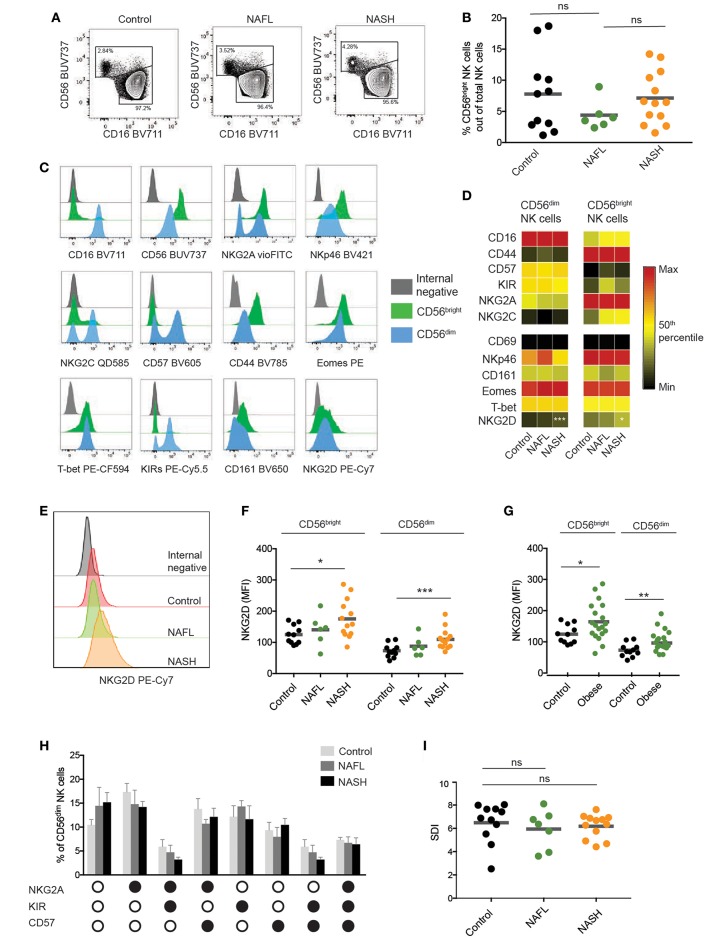
Phenotypic characterization of circulating NK cells from NAFLD patients. (A) Representative flow cytometry plots of NK cells from healthy, NAFL, and NASH patients. (B) Frequency of CD56bright NK cells out of total NK cells in peripheral blood of healthy controls (n = 13), NAFL patients (n = 9), and NASH patients (n = 16). (C) Representative histograms for the indicated markers on CD56bright and CD56dim NK cells as well as internal negative control. The plots represent stainings from one healthy donor. (D) Heat map depicting the mean frequency of NK cells expressing CD16, CD44, CD57, KIRs, NKG2A, and NKG2C as well as the mean MFI of CD69, NKp46, CD161, Eomes, T-bet, and NKG2D on CD56dim and CD56bright NK cells for the indicated groups. (E) Representative histogram of NKG2D expression on NK cells from healthy control, NAFL, and NASH patients respectively. (F,G) Scatter plots of NKG2D MFI on CD56dim and CD56bright NK cells from the indicated groups. In (F), healthy controls (n = 11), NAFL (n = 6), and NASH (n = 13) patients, in (G) healthy controls (n = 11), obese individuals (n = 18). (H) Bar graph showing the frequency of CD56dim NK cells that express different combination of NKG2A, KIRs, and CD57. Black circles indicate presence of the marker and white circles no expression. (I) Inverse Simpson Diversity index (SDI) analysis for healthy (n = 11), NAFL (n = 7), and NASH patients (n = 12). The Mann–Whitney U-test was used for comparison between groups. Bars in (B,F,G,I) show mean, error bars in H represent SEM. *p < 0.05, **p < 0.01, ***p < 0.001.